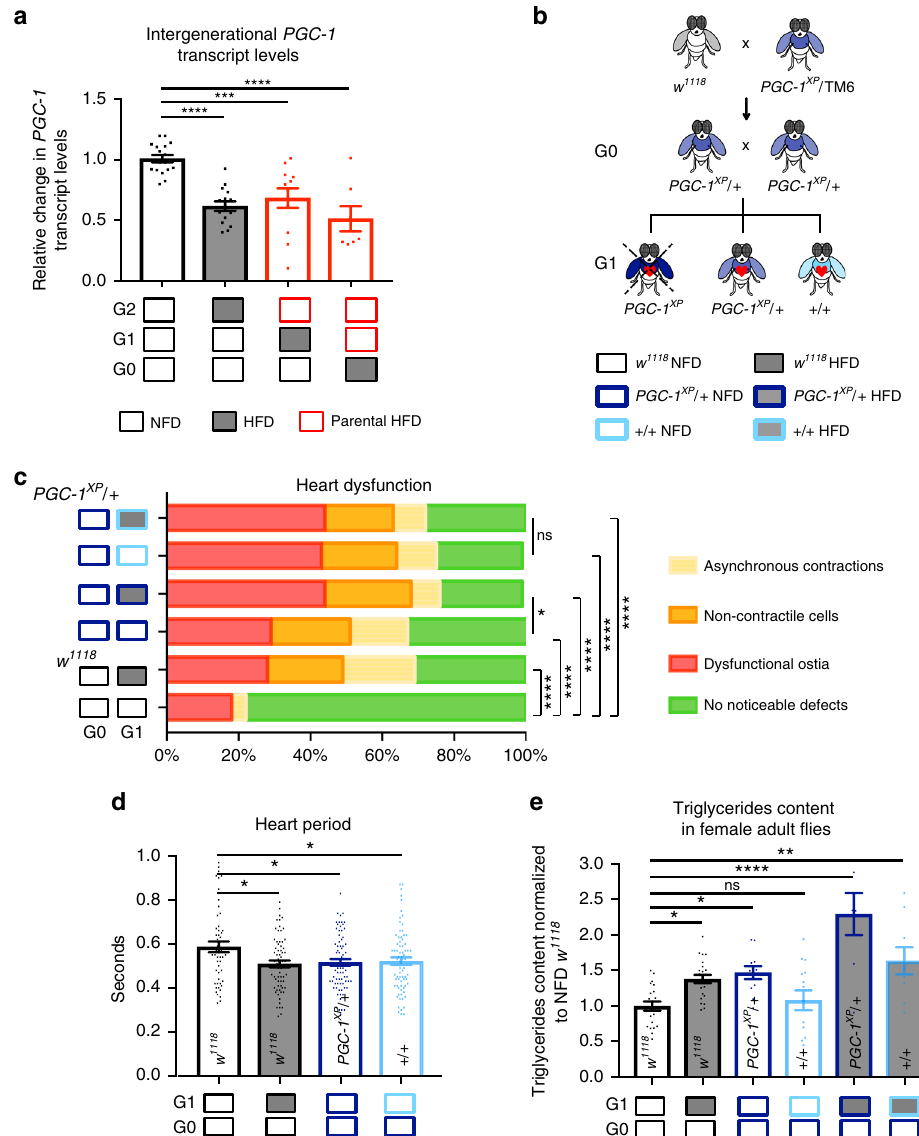
Fig. 3 Depletion of PGC-1 causes changes in fat content and heart function in the next generation. a PGC-1 transcript levels of whole fl ies fed NFD, acute HFD, or parental HFD. PCG-1 mRNA levels are normalized to rp49 ( n = 7 – 17 samples per condition consisting of more than 6 female fl ies each from